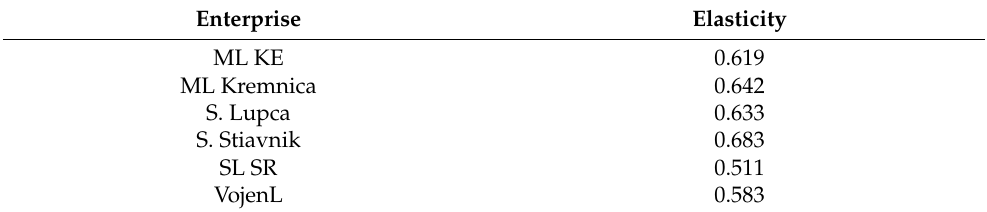
Table 10. SIZE elasticities (slopes) of leverage for the Slovak forest enterprises.